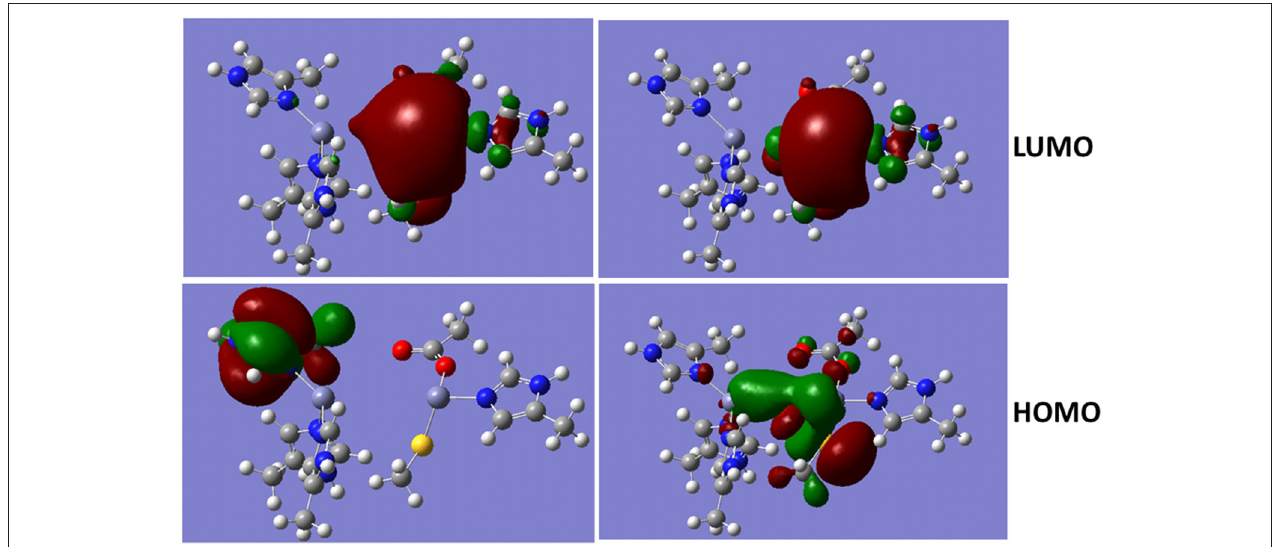
FIGURE 4 | Molecular Orbital presentations (LUMO and HOMO) of QM region obtained using Guassian09. Left panel is NDM-1 without bridged hydroxide ion (PDB 4EXS, King et al., 2012) and Right Panel is NDM-1 in which a hydroxide ion is located between two Zinc ions (PDB 3Q6X, Zhang and Hao, 2011). Figures